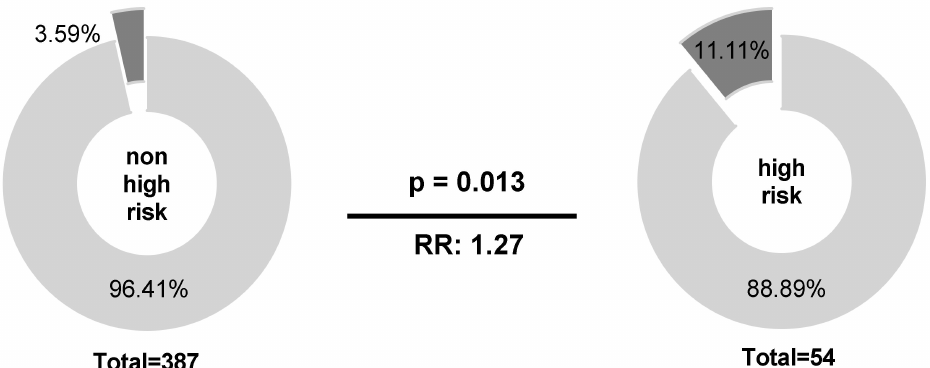
Figure 1. Correlation of IPI score and the NKG2C − / − status. Higher frequencies of the NKG2C − / − could be observed for patients in the IPI high-risk group (IPI 4–5) compared to those in the non-high-risk group (IPI 0–3; low to high-intermediate risk). NKG2C − / − (dark grey), NKG2C +/ − or NKG2C +/+ (light grey). Clinical data were not available for all